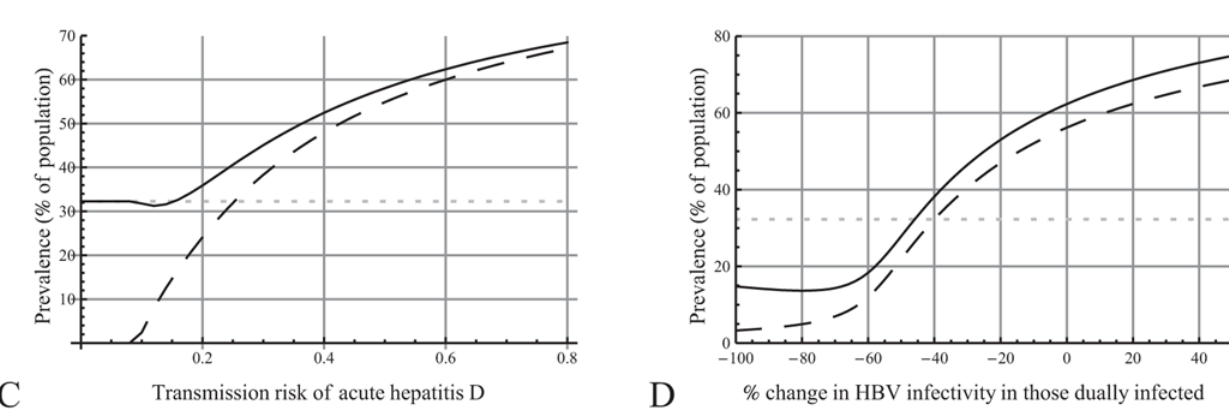
Figure 4. How the characteristics of hepatitis D affect the endemic prevalences of hepatitis B (HBV) and hepatitis D. The plot shows the prevalences of HBV (solid line) and hepatitis D (dashed line) in a population where both viruses are circulating and the prevalence of HBV in a population where only HBV is circulating (grey dotted line). A. The transmission probability of acute hepatitis D ( q d 1 ) was varied from 0 to 0.8 and that of chronic hepatitis D ( q d 2 )was 0.65 times that of acute hepatitis D. B. The percentage change in HBV infectivity in those dually infected (compared to those with single HBV infection, 100 (cid:1) q bj { p bj (cid:1) (cid:2)(cid:5) p bj , for j =1, 2) was varied from 2 100% to + 50%. C, D. As in plots A, B, but assuming that HBV carriers who are superinfected with hepatitis D do not re-enter acute HBV (using equations (2) instead of the last two equations of system (1)).